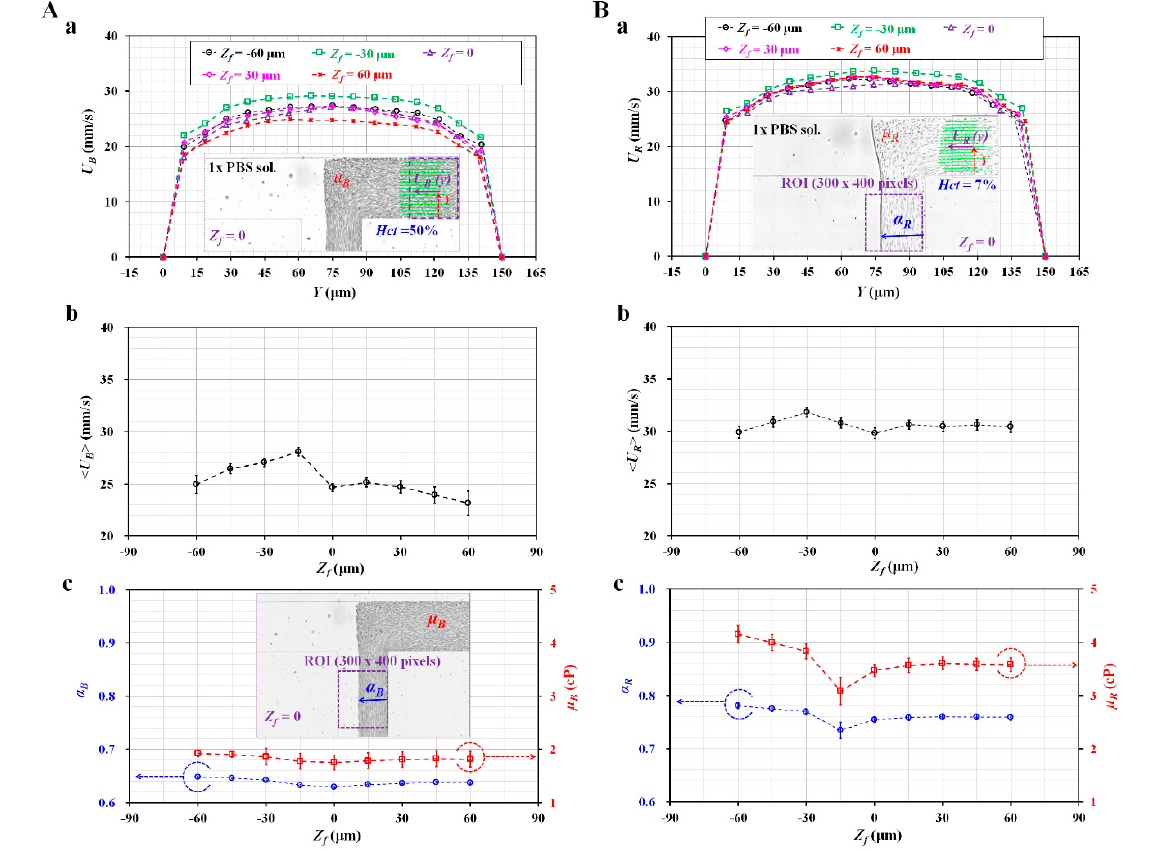
Figure A4. Effect of the relocation of object plane ( Z f ) on velocity, interface, and viscosity with respect to the blood sample and reference fluid. A blood sample ( Hct = 50%) was prepared by adding normal RBCs into a 1× PBS. A reference fluid with RBCs ( Hct = 7%) was prepared by adding normal RBCs into a 40% glycerin solution. Both fluids were delivered to inlets at a constant flow rate of 1 mL/h with two SPs. ( A ) Effects of the relocation of object plane on velocity, interface, and viscosity for the blood sample. ( a ) Variations of U B across reference channel width with respect to Z f = − 60, − 30, 0, 30, and 60 μ m. The inset depicted the velocity profile of the blood sample flowing in the reference channel at Z f = 0. ( b ) Variations of < U B > with respect to Z f . ( c ) Variations of α B and μ B with respect to Z f . The inset showed interfacial location ( α B ) at Z f = 0. ( B ) Effect of the relocation of object plane on velocity, interface, and viscosity for reference fluid with RBCs ( Hct = 7%). ( a ) Variations of U R across reference channel width with respect to Z f = - − 60, − 30, 0, 30, and 60 μ m. The inset represented U R and α R at Z f = 0. ( b ) Variations of < U R > with respect to Z f . ( c ) Variations of α R and μ R with respect to Z f .